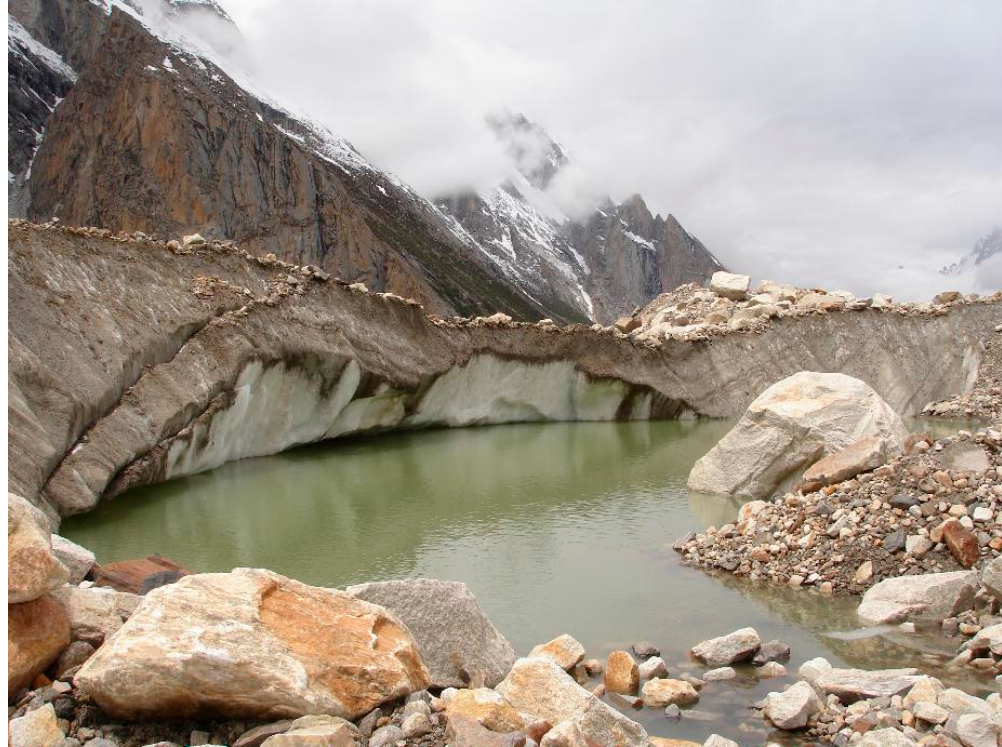
Figure 6. A large supraglacial lake surrounded by ice cliffs on Blatoro glacier (photo credit: Andrew G.B. Bush, 2005).